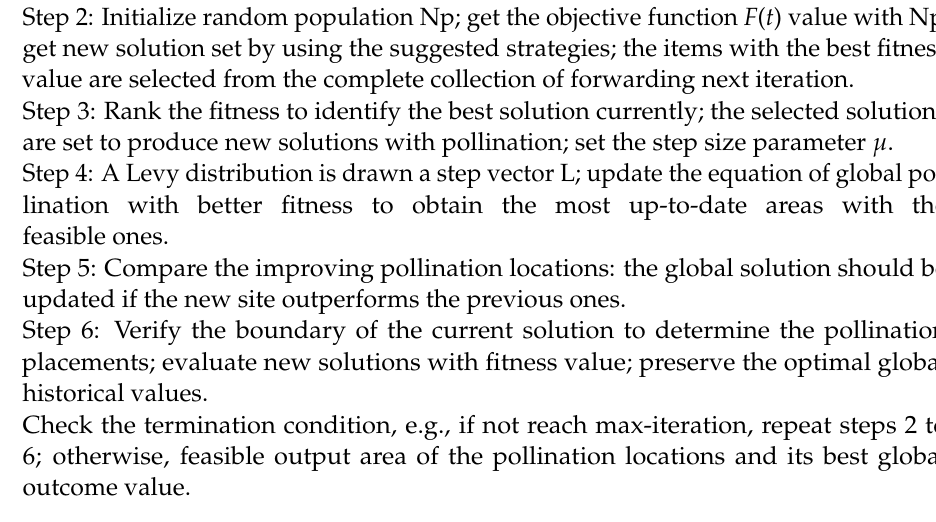
Table 6. The relevant parameters of each unit of the operation model of the power